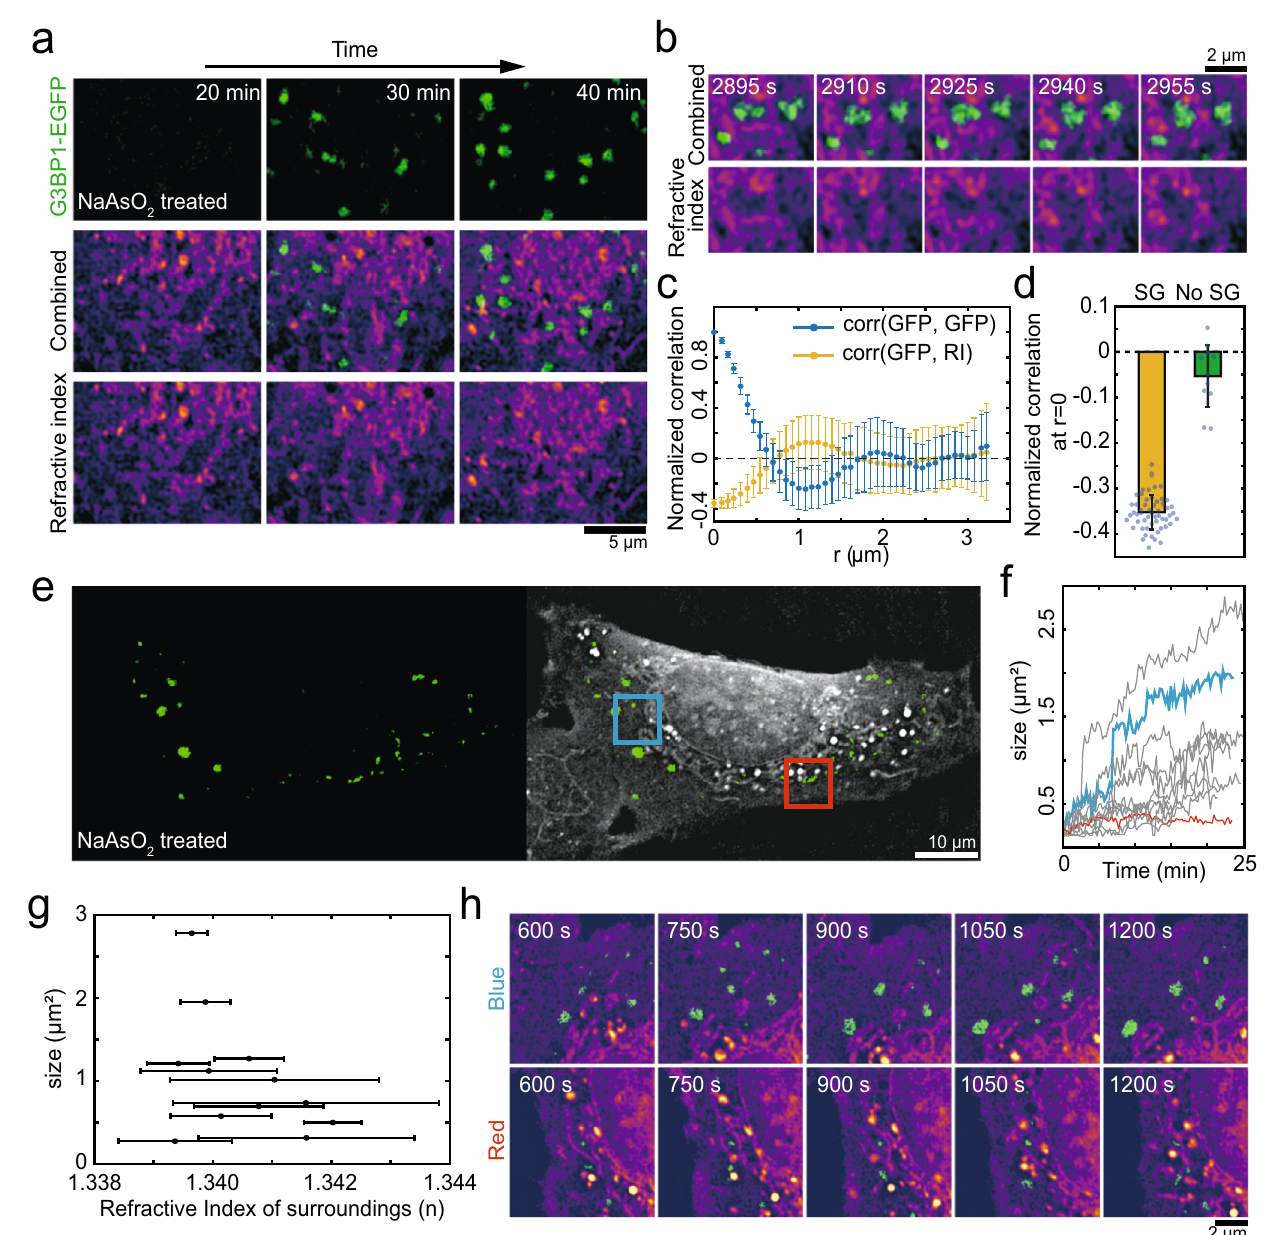
Fig. 5 | Intracellular structures in fl uence the distribution, morphology and growth of condensates. a Time-lapse images of stress granule formation within the G3BP1-EGFP expressing U2OS cell after the treatment of 500 μ M sodium arsenite. b Zoomed-in images of the same cell in ( a ). c Normalized 2D auto- correlation of G3BP1-EGFP images and cross-correlation between G3BP1 and RI images.Plottedaretheaverage( fi lledcircles)andstandarddeviation(errorbars)of the correlation, at each binned radial shift ( n =11). d For zero radial shift, normal- ized cross-correlation values between G3BP1 and RI images are plotted in the presence and absence of stress granules. n =55 (with stress granule) and 11 (no stress granule). Error bar was de fi ned as standard deviation. e Combined RI and fl uorescence images of a live G3BP1-EGFP expressing U2OS cell one hour after